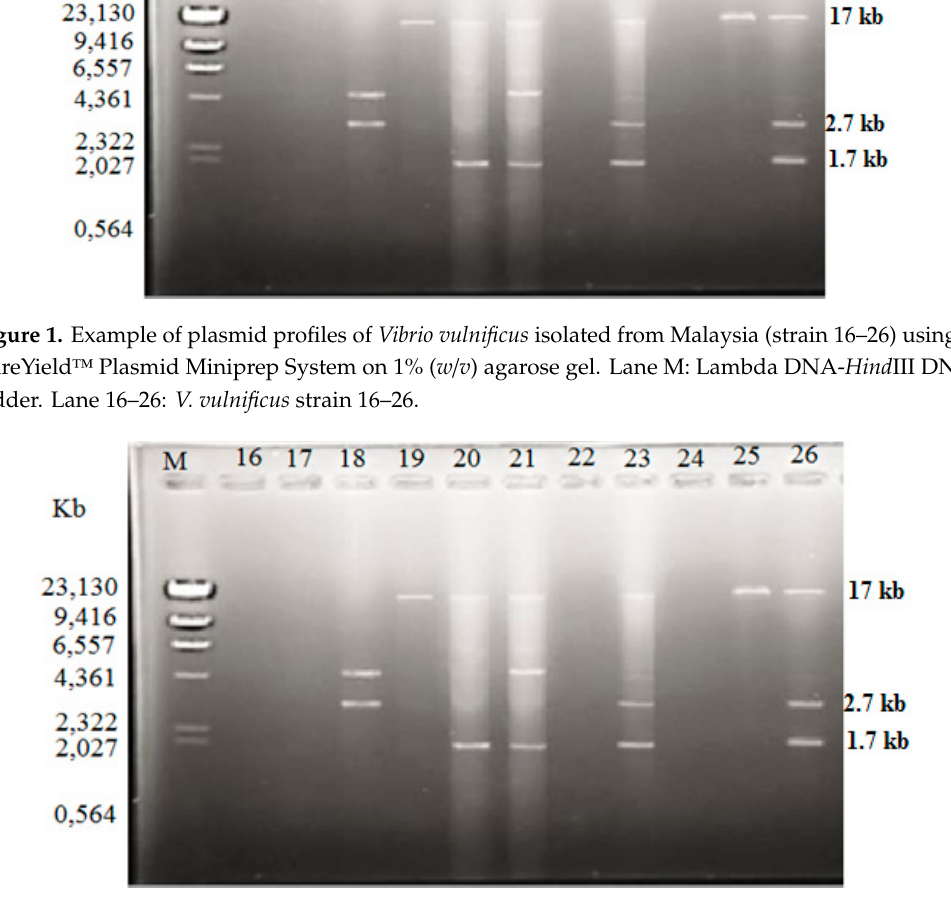
Figure 2. Example of plasmid profiles of Vibrio vulnificus isolated from Qatar (strain 32–37, Malaysia; strain 38–46, Qatar) using a PureYield™ Plasmid Miniprep System on 1% ( w / v ) agarose gel. Lane M: Lambda DNA-HindIII Digest DNA ladder. Lane 47–60: V. vulnificus strain 47–60; NC: negative control.